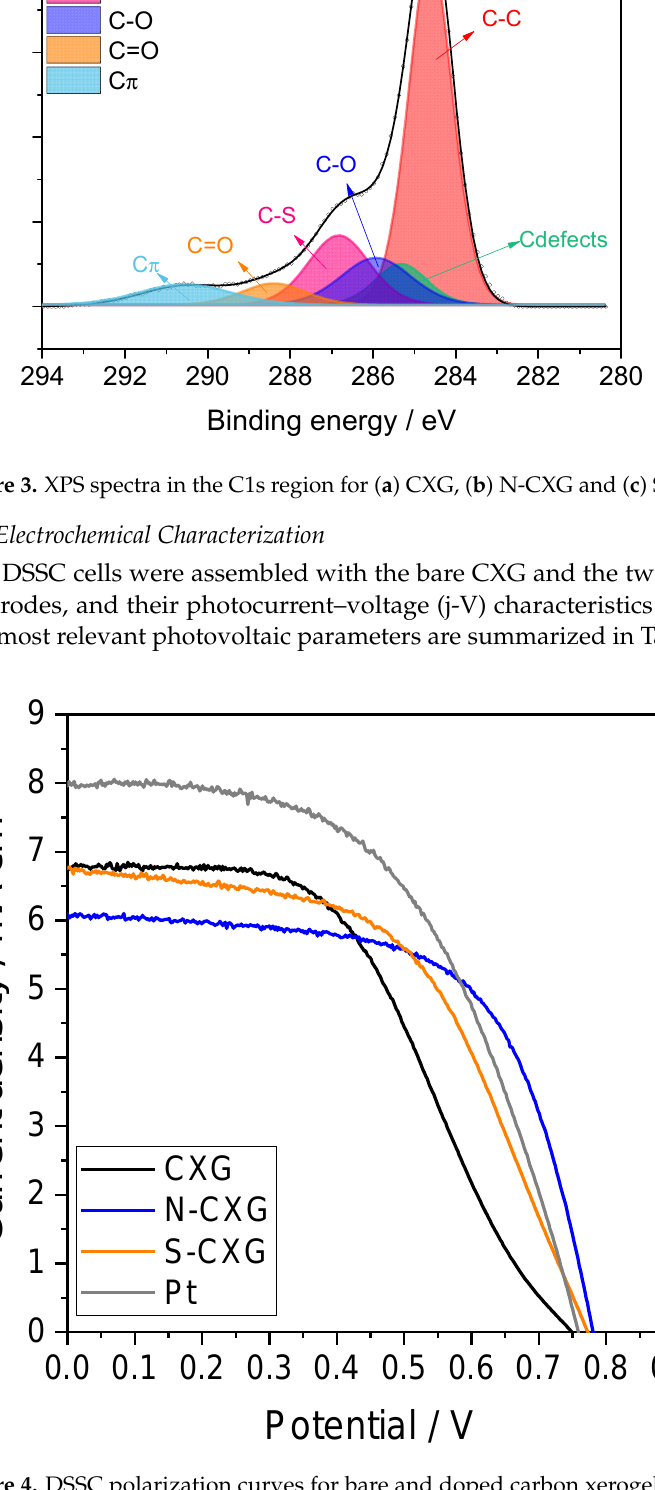
Figure 4. DSSC polarization curves for bare and doped carbon xerogels as counter electrodes and compared with Pt. By comparing the different polarization curves, the doping of carbon xerogels clearly influences their behavior as counter electrodes. On the one hand, the open circuit potential